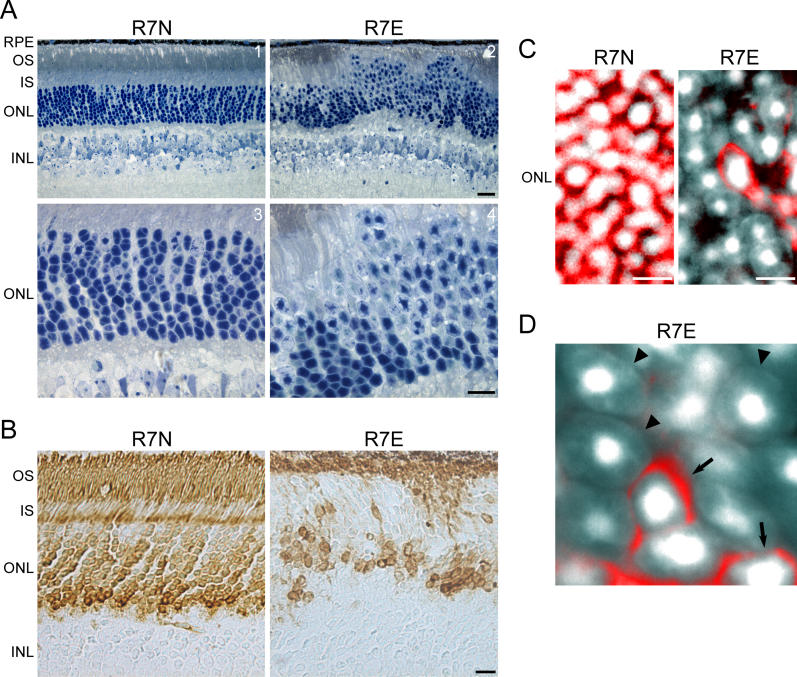
Chromatin Remodeling in Rod Nuclei Paralleled Segment Loss andRho Down-Regulation in SCA7 Mice(A) Histological examination of retina from 2-mo-old R7N (panels 1 and 3) and R7E (panels 2 and 4) mice. Toluidin-blue staining of semi-thin sections revealed a discontinuous pattern of segment loss which paralleled an irregular appearance of rod chromatin decondensation in R7E animals (upper panels). High magnification micrographs (lower panels) showed that rods with preserved nuclear morphology are connected with inner segments of normal appearance. Scale bars represent 20 μm in upper panels and 10 μm in lower panels.(B–D) Rhodopsin immunolocalization in 2-mo-old R7N and R7E retina.(B) Immunohistochemistry of paraffin-embedded sections was performed using an anti-rhodopsin antibody (4D2). In R7E retina, residual staining was observed in the innermost part of the ONL and in folds in which normal condensed rod nuclei were typically located. Scale bar represents 10 μm.(C and D) Immunofluorescence of retinal cryosections were performed using an anti-rhodopsin antibody (4D2) and DAPI to visualize rod nuclei. Images were collected by confocal imaging analysis, and merged images (rhodopsin in red, DAPI in grey scale) are shown. (C) Very few cells retained rhodopsin staining, which circumscribes the nucleus in the ONL. (D) Higher magnification images demonstrated that residual staining was exclusively found in rods showing a preserved nuclear morphology (arrows), whereas no rhodopsin could be detected in rods showing an altered chromatin organization (arrowheads). Scale bar represents 5 μm.INL, inner nuclear layer; IS, inner segments; RPE, retinal pigment epithelium.